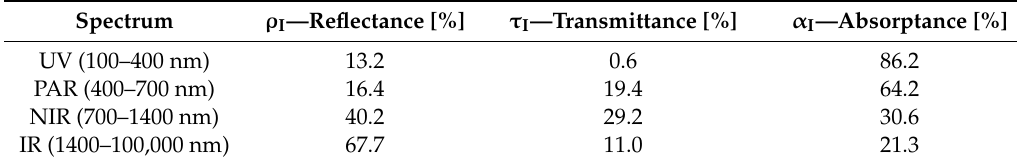
Table 1. Optical properties of OPV structure I.